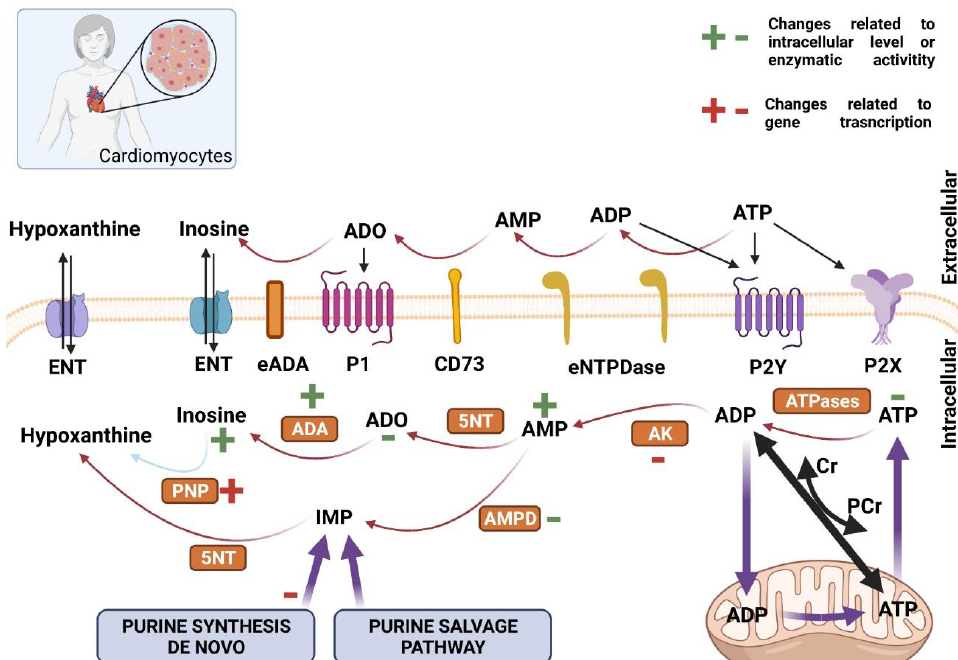
Figure 3. Purine metabolism and signaling in healthy and Huntington’s disease cardiomyocytes. In cardiomyocytes, ATP is heavily produced by mitochondria and transported to the cytosol through the phosphocreatine shuttle. In the cytosol, many enzymes (orange boxes) can convert ATP to AMP, ADO, IMP, inosine, and hypoxanthine. The later ones can be transported to the extracellular milieu by ENT. Extracellularly, ATP can also be converted to inosine through a similar cascade by extracellular-faced enzymes anchored to the cell membrane. CD73 is the only extracellular 5NT. Pathophysiology of Huntington’s disease exerts alterations in the activity of enzymes (marked in green +/-) or by genomic expression (marked in red +/-). P1 —Adenosine receptor; P2X —ATP receptor channel; P2Y —ATP/UTP receptor; ATPases —adenosine-5′-triphosphatases; AK —adenylate kinase; eNTPD —ecto-nucleoside triphosphate diphosphohydrolase; AMPD —AMP deaminase; 5NT —5′ nucleotidase; CD73 —ecto-5′ nucleotidase; eADA —ecto-adenosine deaminase; ADA— adeno-